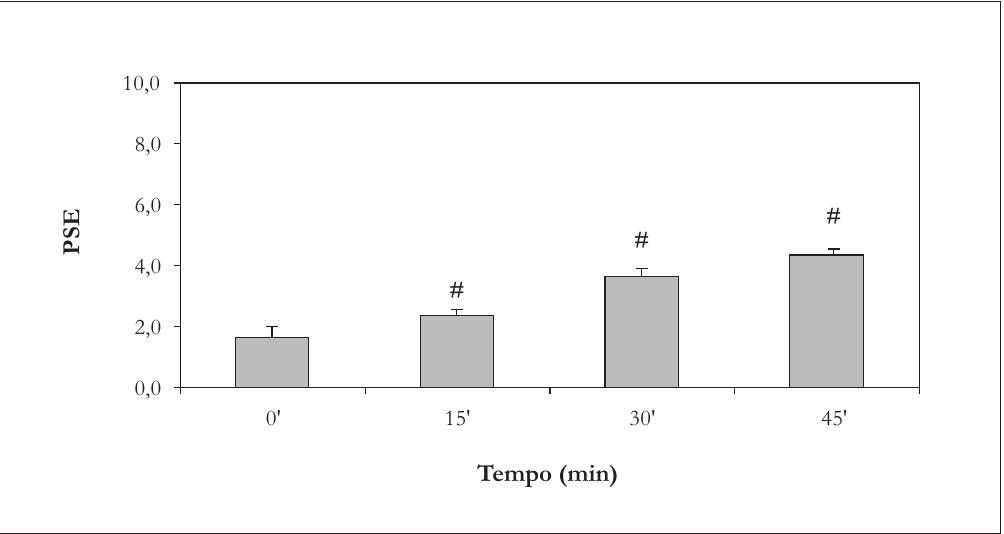
Figura 1 - Percepção subjetiva de esforço nos intervalos de 0 a 45 min. Os valores representam a média ± e.p.m. das 6 sessões de fisioterapia. # p ≤ 0,05 em relação a todos os tempos analisados (Teste t de Student pareado)